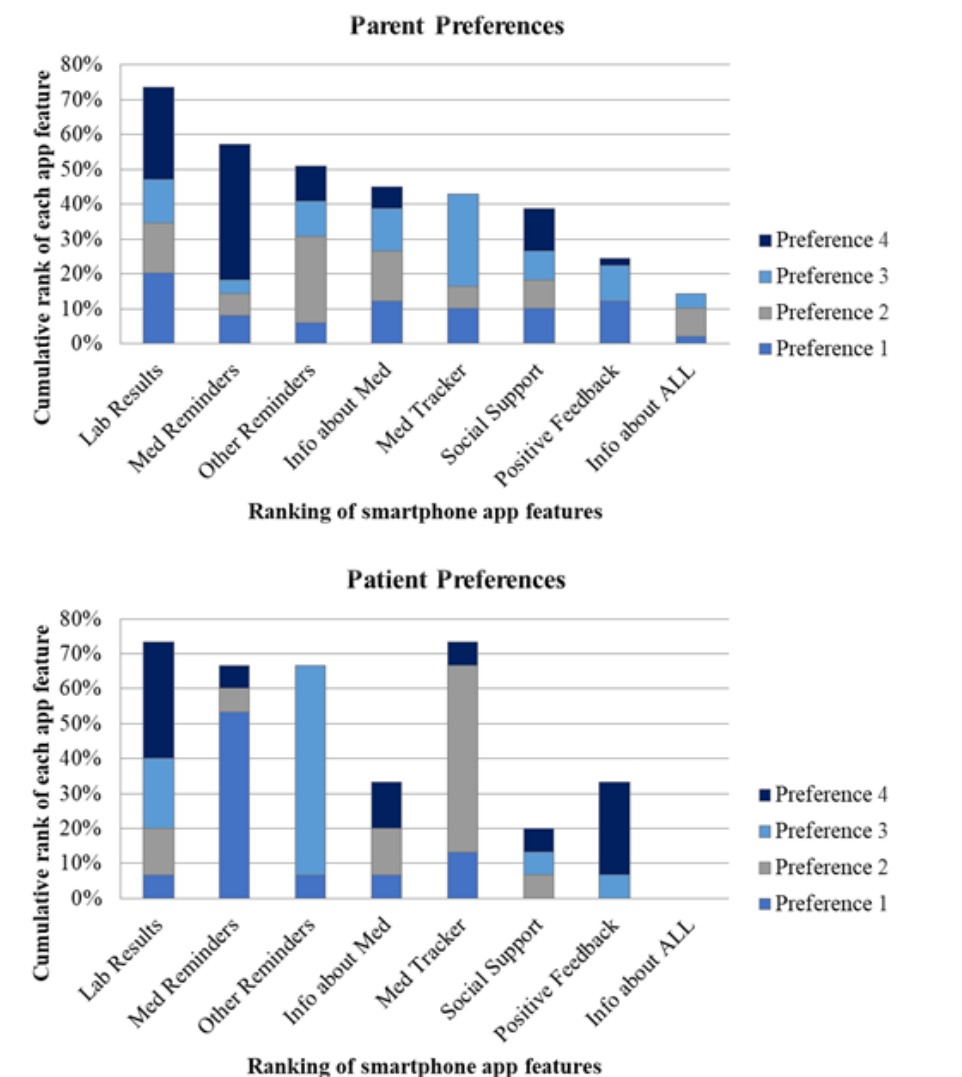
Figure 3. Participants’cumulative ranking of smartphone adherence app